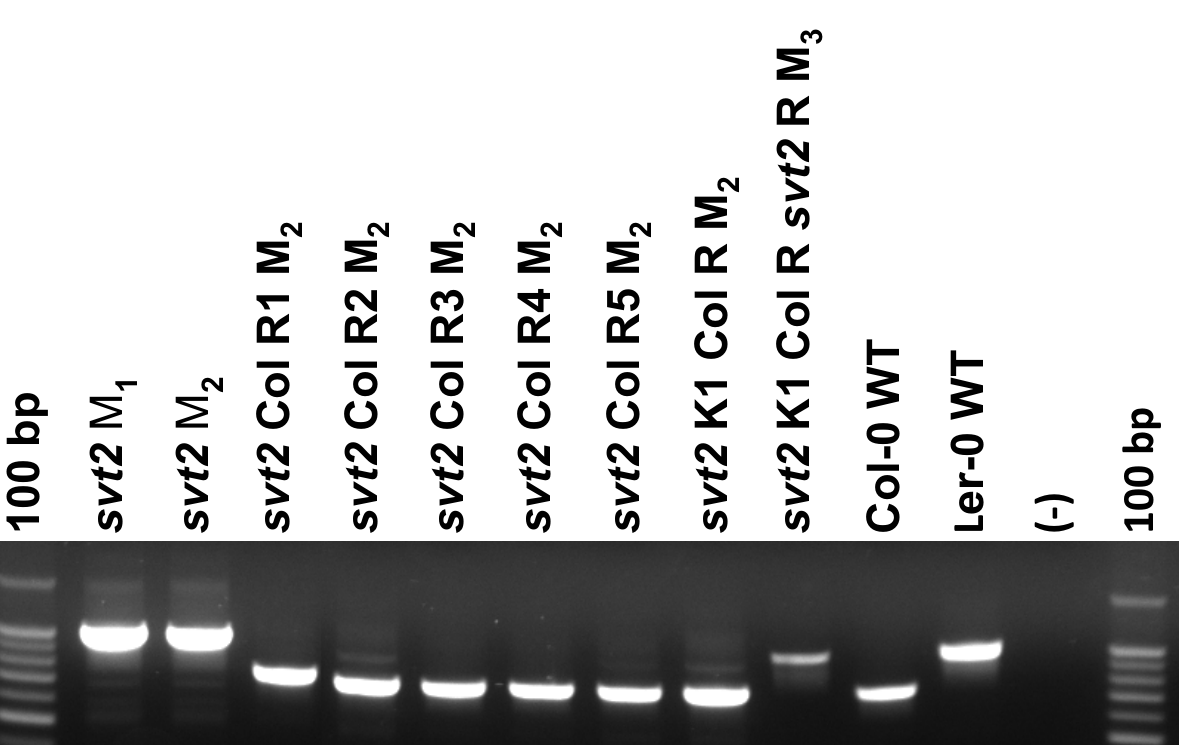
Figure 9. Insertion/Deletion polymorphism analysis in svt2 , Col-0, L er -0, and revertants. PCR amplification of the Col/Ler VTC1 promoter polymorphism in svt2 plants and svt2 revertant (R) plants, amplified with the VTC1 G1F and G2R primers. (-) indicates negative control, no DNA.